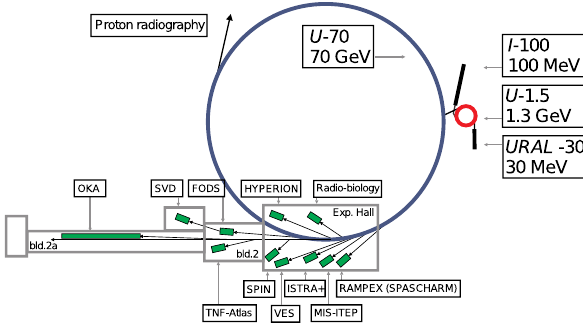
Fig. 2 Schematic view of the Protvino accelerator